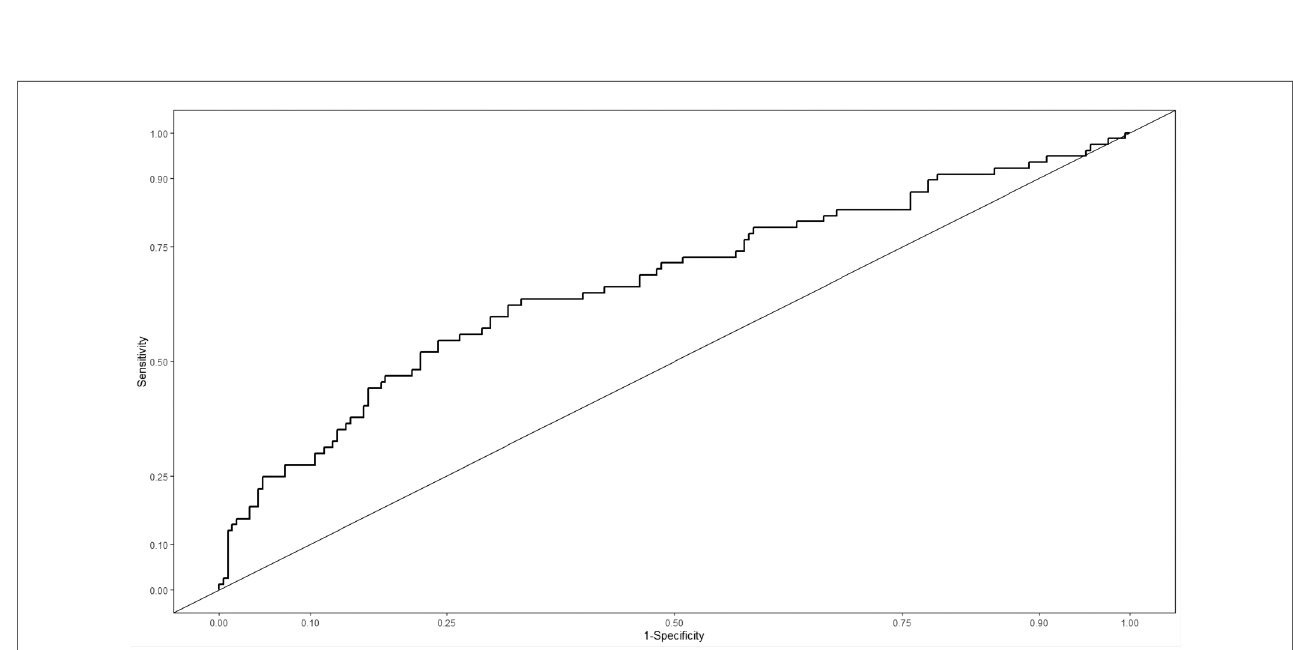
FIGURE 5 Calibration plots of the nomogram. The solid line represents the bias-corrected performance of the nomogram, where a closer fi t to the diagonal dotted line represents a better